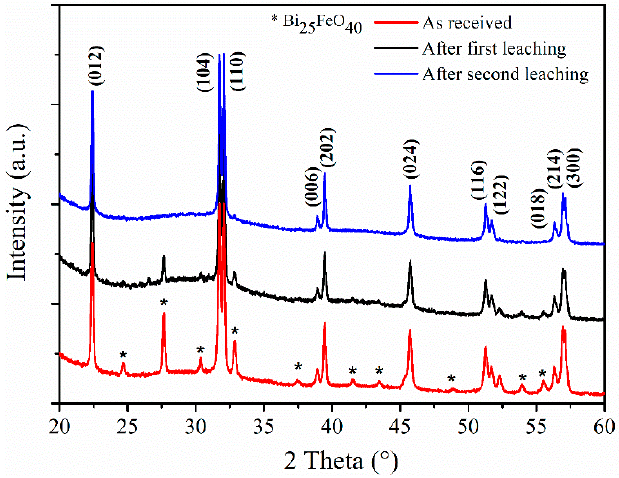
Figure 2. X-ray diffraction patterns of BiFeO 3 compound for (red) as received sample, (black) after the first and (blue) second leaching with acetic acid. (*) indicates Bi 25 FeO 40 picks positions.